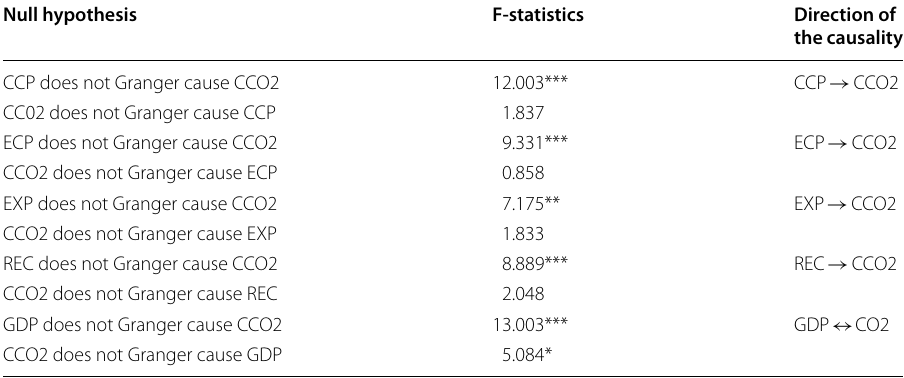
Table 6 Short-run causality